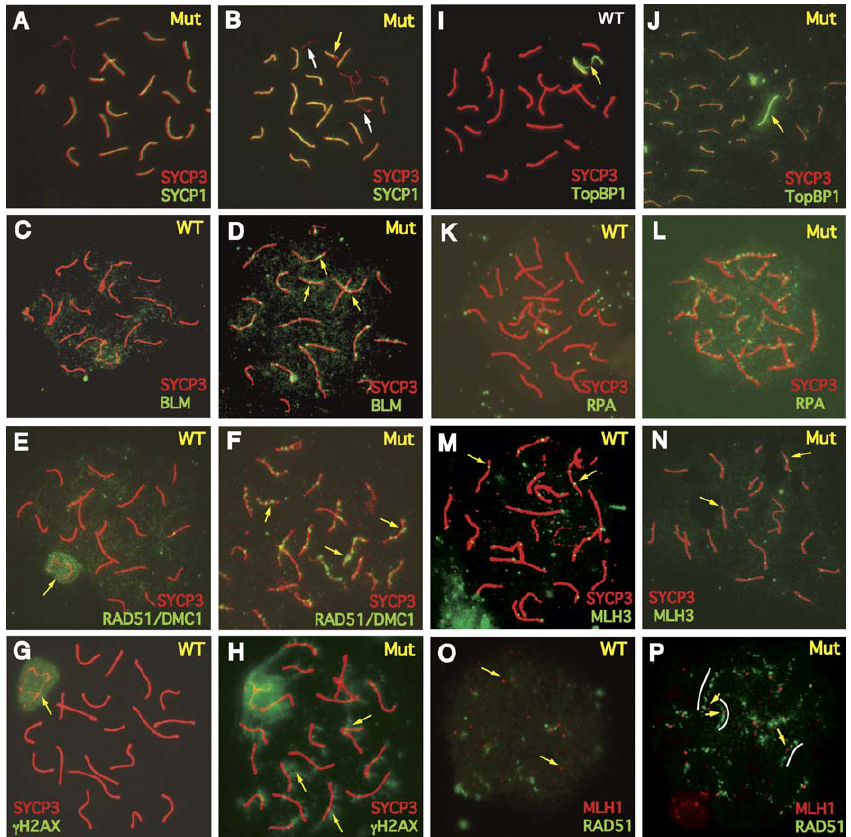
Figure 4. Immunohistochemical Analysis of Pachytene Spermatocyte Chromosomes Surface-spread chromosomes were immunolabeled with the indicated antibodies and fluorophores. As indicated in the upper right of each panel, cells were from wild type (WT, either þ / þ or Trip13 Gt/ þ ) or Trip13 Gt/Gt (Mut). There were no differences seen between heterozygotes and þ / þ spermatocytes. (A) A mutant pachytene nucleus with full synapsis. Areas of SYCP1/SYCP3 colabeling are yellow. (B–E) Spermatocytes nucleus from 17.5 d postpartum mutant. Asynapsed chromosomes or regions of chromosomes are indicated by white and yellow arrows, respectively. Unlike the normal distribution in wild-type pachytene spermatocytes (C), BLM foci are present on synapsed pachytene chromosomes in the mutant (D). RAD51 foci, which are abundant earlier in prophase, disappear from autosomes in wild-type pachytene nuclei (E) and the bulk of staining is over the XY body (arrow). (F) RAD51 persists on the synapsed mutant chromosomes (arrows). (G) H2AX phosphorylation is restricted to the XY body in WT. (H) In addition to a large area of c H2AX staining (arrow) over the XY body, there is extensive autosomal H2AX phosphorylation (arrows). (I, J) Note that in wild-type pachytene spermatocytes, TOPBP1 is present only over the XY body (yellow arrow). In the mutant (J), an arrow denotes one area of intensive staining that may be over the sex chromosomes, but many other chromosome cores are positively stained. (K, L) RPA persists along synapsed cores in the mutant, not WT. (M, N) Arrows indicate examples of MLH3 foci on SCs. (O) In WT late pachytene spermatocytes, RAD51 is present only at background levels. (P) As in (F), extensive RAD51 staining delineates SCs in mutant pachytene nuclei (indicated by white arcs). MLH1 foci colocalize with these tracts (arrows) at the typical 1–2 foci per chromosome as in (M).